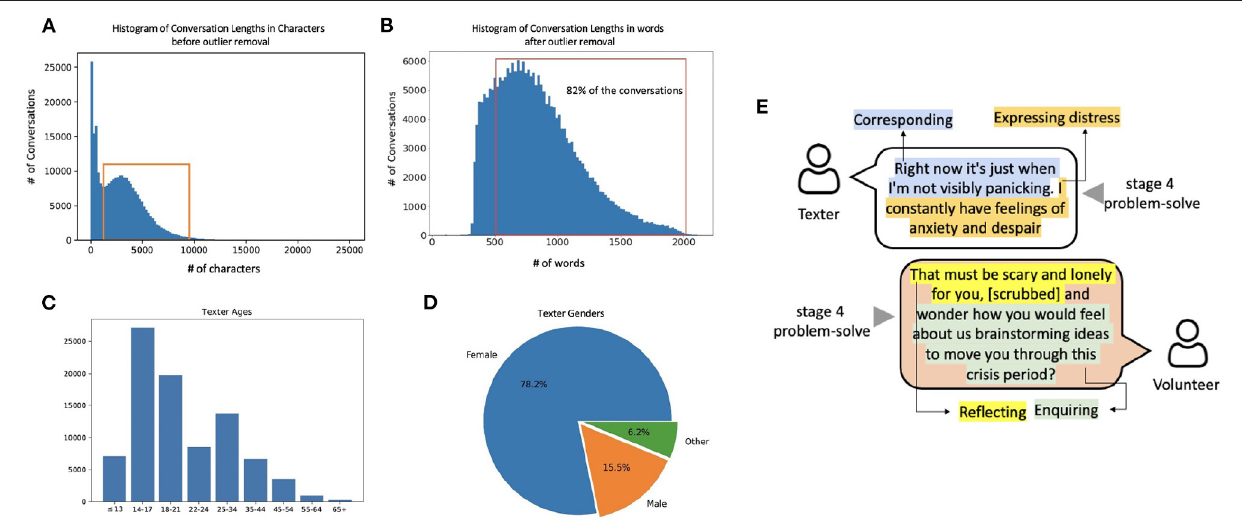
FIGURE 1 | High-level overview of the Shout data set. (A) The distribution of conversation lengths as measured by the number of characters. The red box indicates the conversations between 1,200 and 9,200 characters which passed the inclusion criteria for analysis. (B) The histogram of the number of words in a conversation. Since 82% of the conversations exceed the maximum word limit (512 words) of traditional BERT-style NLP models, we use the Longformer model. (C) Age distribution and (D) gender distribution of texters as obtained from the texter surveys (which we show in section 3.3 to be biased toward particular demographic groups). (E) A synthetic example of a portion of a conversation to illustrate annotations of behaviours and conversation stages.